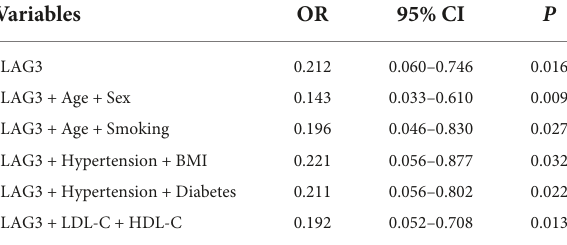
Multivariable logistic regression analyses were performed to identify the correlation of sLAG3 with CAD. The sLAG3 was transformed into dichotomous variables according to median of sLAG3. sLAG3, soluble lymphocyte activation gene-3; BMI, body mass index; HDL-C, high-density lipoprotein cholesterol; LDL-C, low-density lipoproteincholesterol.